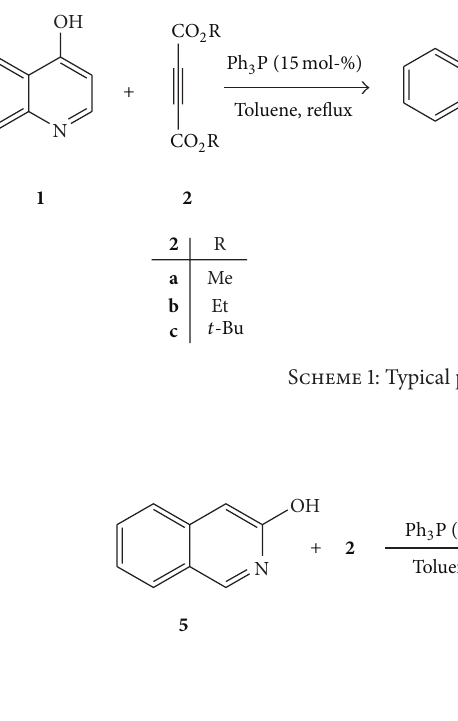
Scheme 2: Procedure for synthesis of compound 6